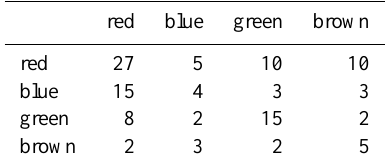
Table 1. Parameters P 0 Table 2. Interaction matrix k in system 3, distinguishing 4 different and s i in example system 3 for 4 different i types of elements. Colours correspond to those in Fig. 4. A number types of elements. Colours correspond to those in Fig. 4. in some row A and column B stands for the impact of any single element of type B on any single element of type A (for example: impact of red on blue: 15, impact of blue on red: